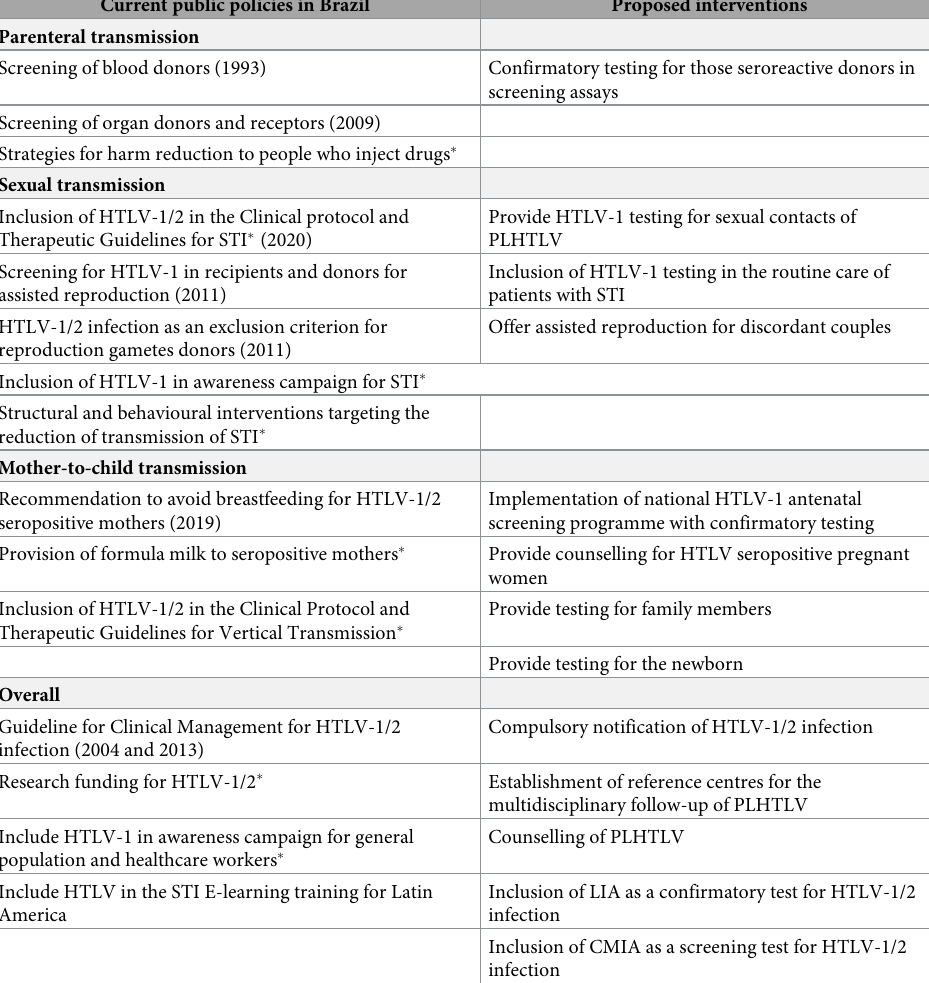
Table 1. Current public health policies towards HTLV-1/2 in Brazil and additional proposed